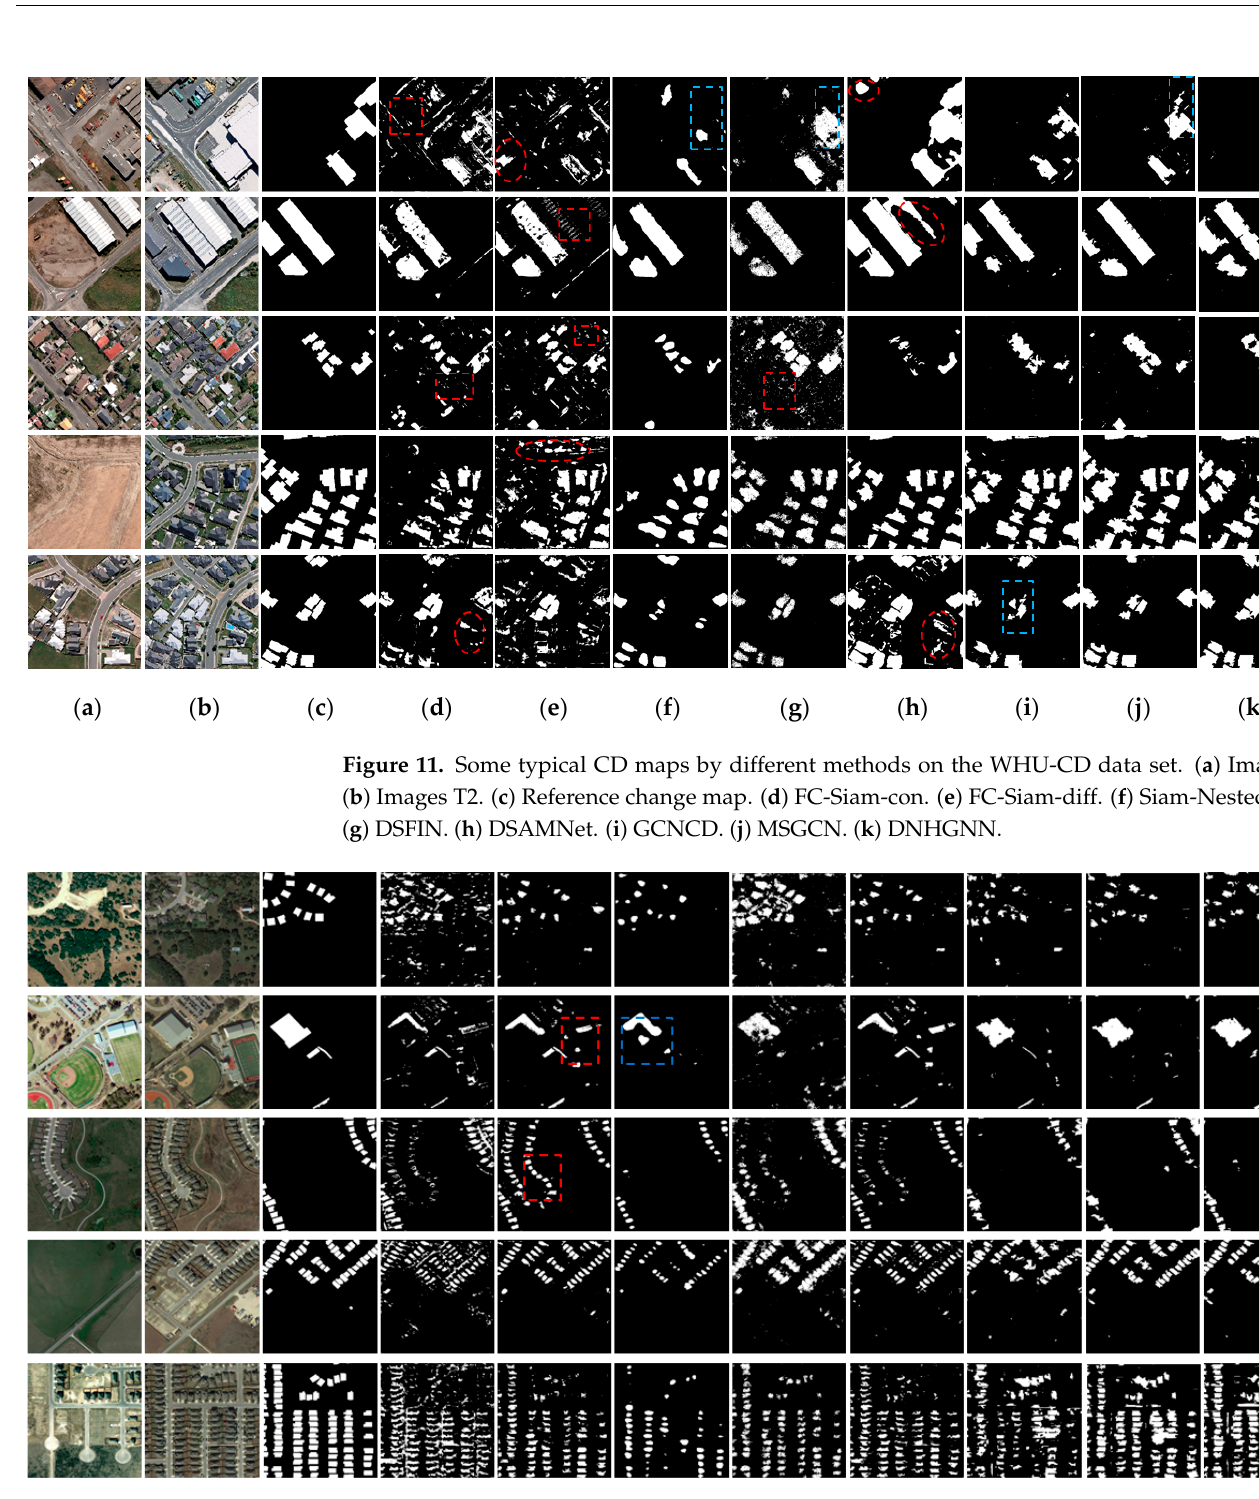
Figure 10. Some typical CD maps by different methods on the SYSU-CD data set. ( a ) Image T1. ( b ) Images T2. ( c ) Reference change map. ( d ) FC-Siam-con. ( e ) FC-Siam-diff. ( f ) Siam-NestedUNet. ( g )